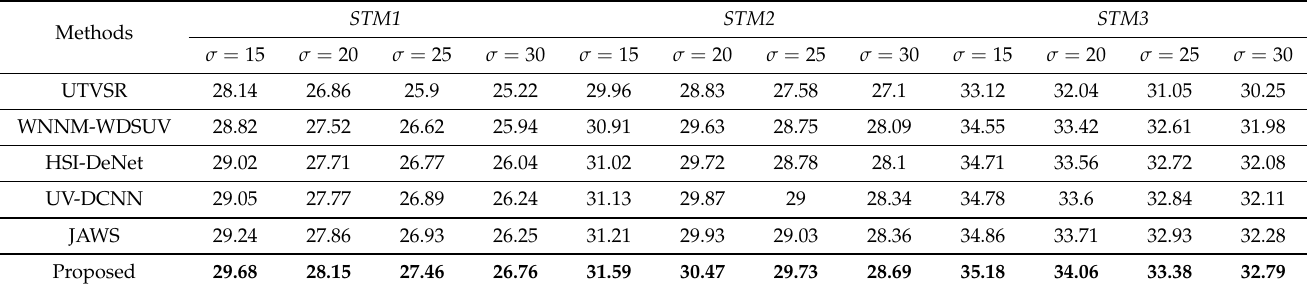
Table 1. Quantitative MPSNR comparisons of the state-of-the-arts on the synthetic optical RSIs shown in Figure